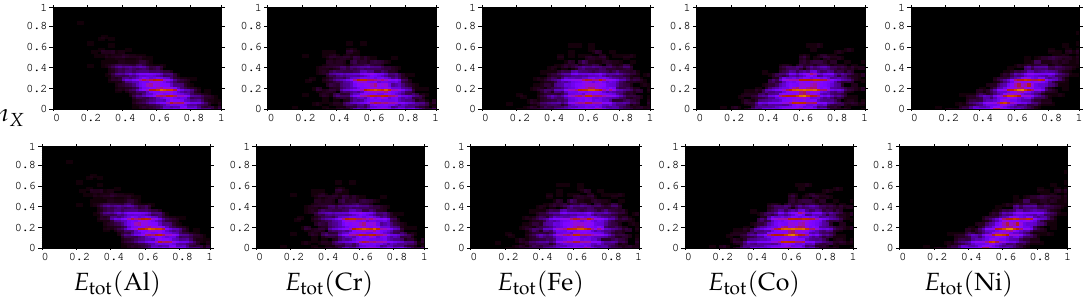
Figure 3. Heatmaps showing the number of samples in scaled ( E tot , n X ) coordinates, with X = Al,Cr,Fe,Co,Ni. Data corresponding to FCC (upper row) and BCC (lower row) is